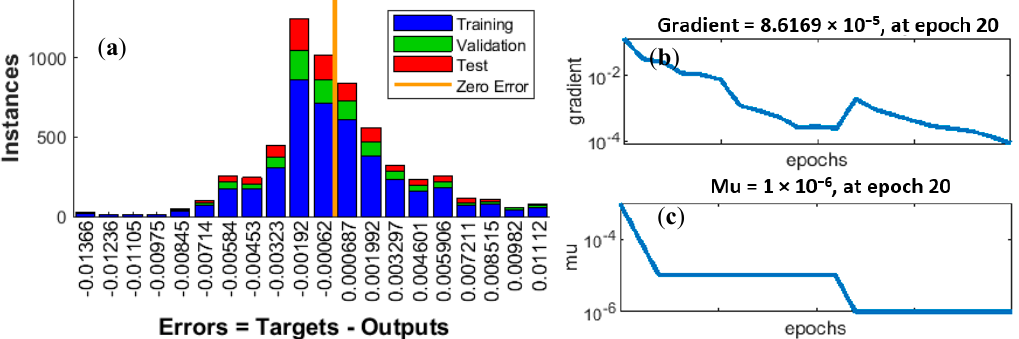
Figure 9. ( a ) Error histogram with 20 bins, ( b ) gradient curve, ( c ) Mu curve.